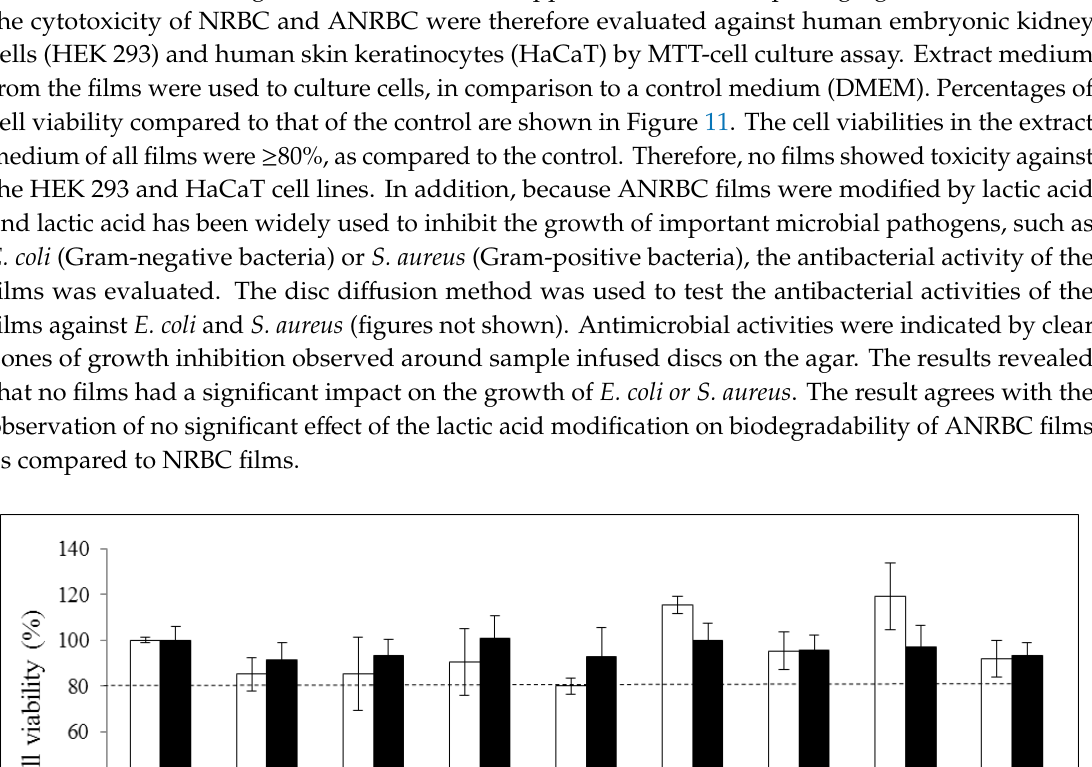
Figure 11. Cell viabilities (%) of HEK 293 ( (cid:3) ) and HaCaT ( (cid:4) ) cultured in extract medium of the NR, BC, NRBC, and ANRBC films for 24 h as compared to the control. the values were expressed as mean ± SD (n = 3).